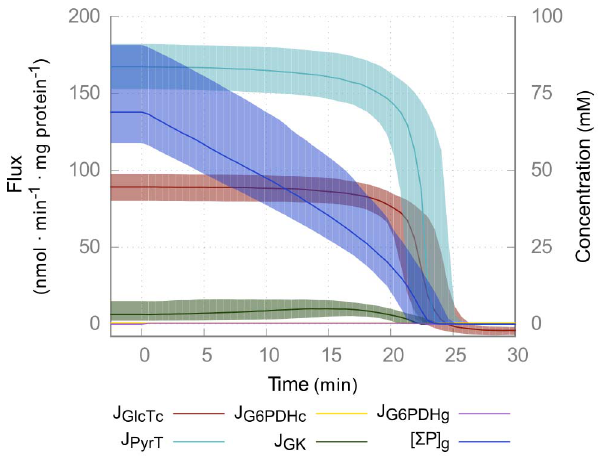
Figure 2. Phosphate leak in model with PPP. Time course simulation of model B, in which the reactions of the glycosomal PPP are switched on at t =0 by increasing their V max value from zero to the value given in Table S1. Glc e is 5 mM and k TOX =2 m l ? min 2 1 ? mg protein 2 1 . Solid lines indicate medians, shaded areas show interquartile ranges. Fluxes (J) are plotted on the left y-axis and are indicative of glucose uptake (GlcT plasma membrane ), glycerol (GK) and pyruvate production (PyrT) and the two branches of pentose phosphate pathways (G6PDH c/g ). The sum of bound phosphates in the glycosome ( S P g ), as exists in the model of glycolysis (Table 2, moiety 5), is plotted on the right y-axis. Within 25 minutes, all bound phosphates within the glycosome are depleted and all metabolic fluxes subsequently drop to zero.